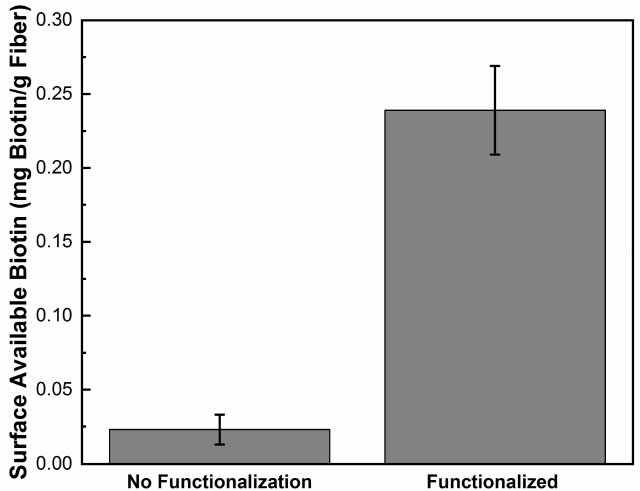
Figure 7. Graph comparing surface available biotin of PLL- g -PEG functionalized silver impregnated nanofiber compared to the fiber with no